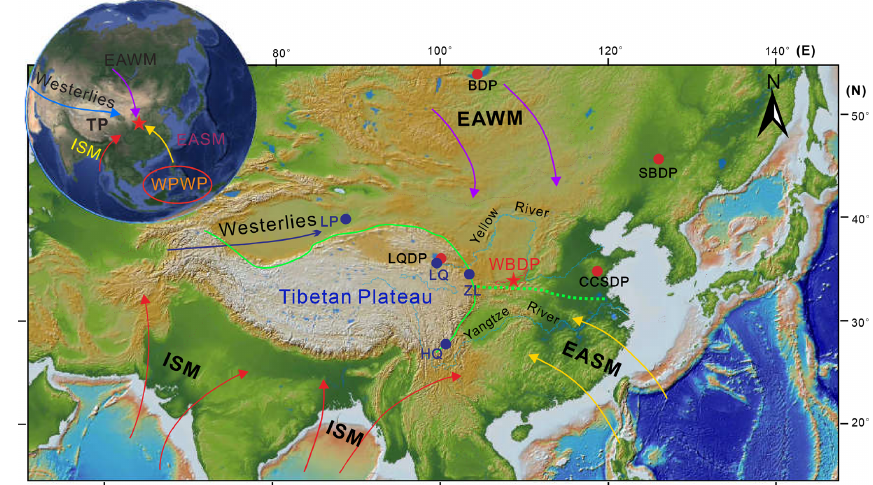
Figure 1. Atmospheric circulation systems in East Asia and locations of previous ICDP (red dots) and CESD (blue dots, Chinese Environ- mental Science Drilling) drilling sites and the proposed site of the Weihe Basin Drilling Project (WBDP; red star). BDP: Lake Baikal; SBDP: Songliao Basin; LQDP: Lake Qinghai; LP: Lop Nur; LQ: Lake Qinghai; ZL: Zhuanglang; and HQ: Heqing Paleolake. ISM: Indian Summer Monsoon; EASM: East Asian Summer Monsoon; EAWM: East Asian Winter Monsoon; and WPWP: West Pacific Warm